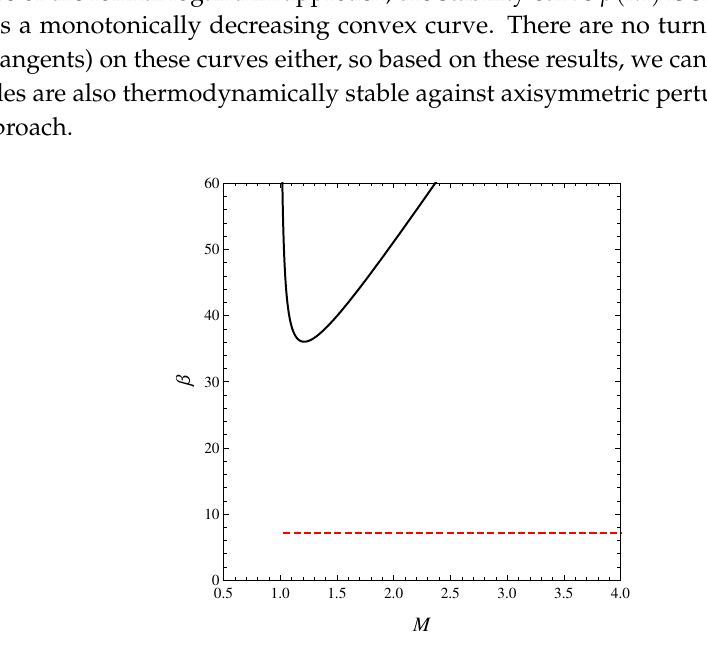
Figure 4. Plots of stability curves β ( M ) at fixed J of standard (black solid) and formal logarithm (red dashed) approaches in the microcanonical treatment. No vertical tangent occurs in either